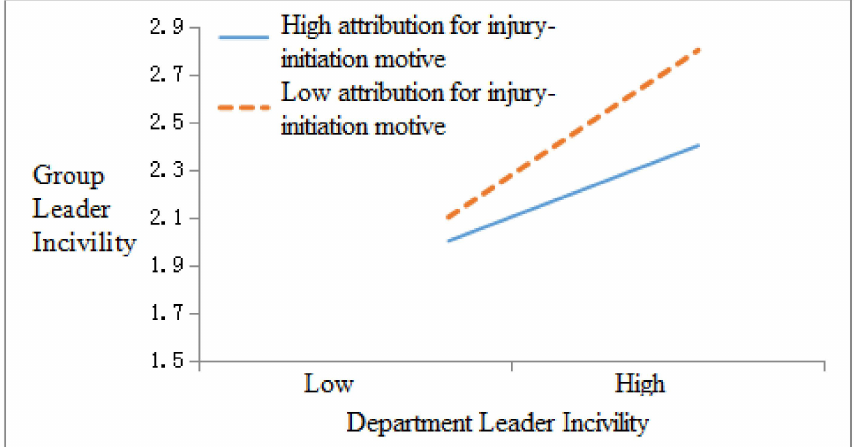
Figure 3. The interactive e ff ect of department leader incivility and group leader attribution for injury initiation motive on group leader